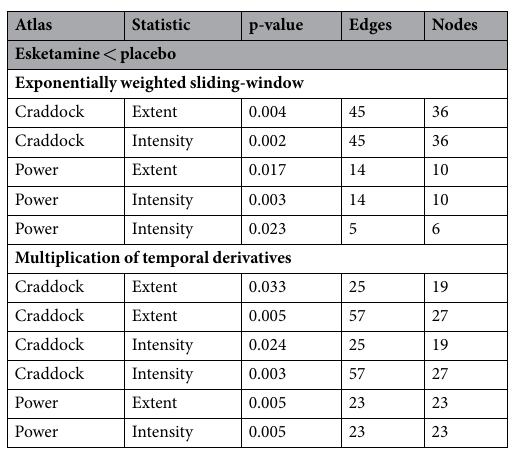
Table 1. Networks in which NBS revealed a negative effect of esketamine on dynamic rsFC. Illustrates networks elucidated through NBS 31 . In these networks, regression coefficients between dynamic rsFC time- course and esketamine plasma levels differed significantly between the esketamine and placebo conditions, demonstrating a significant effect of esketamine on dynamic rsFC. All networks were found for the comparison esketamine < placebo. Edges = number of connections, nodes = number of regions. Exponentially weighted sliding-window based on Zalesky et al . 25 , multiplication of temporal derivatives based on Shine et al . 26 . Craddock and Power denote parcellations based on Craddock et al . 29 and Power et al . 30 . Extent and intensity statistics based on NBS 31